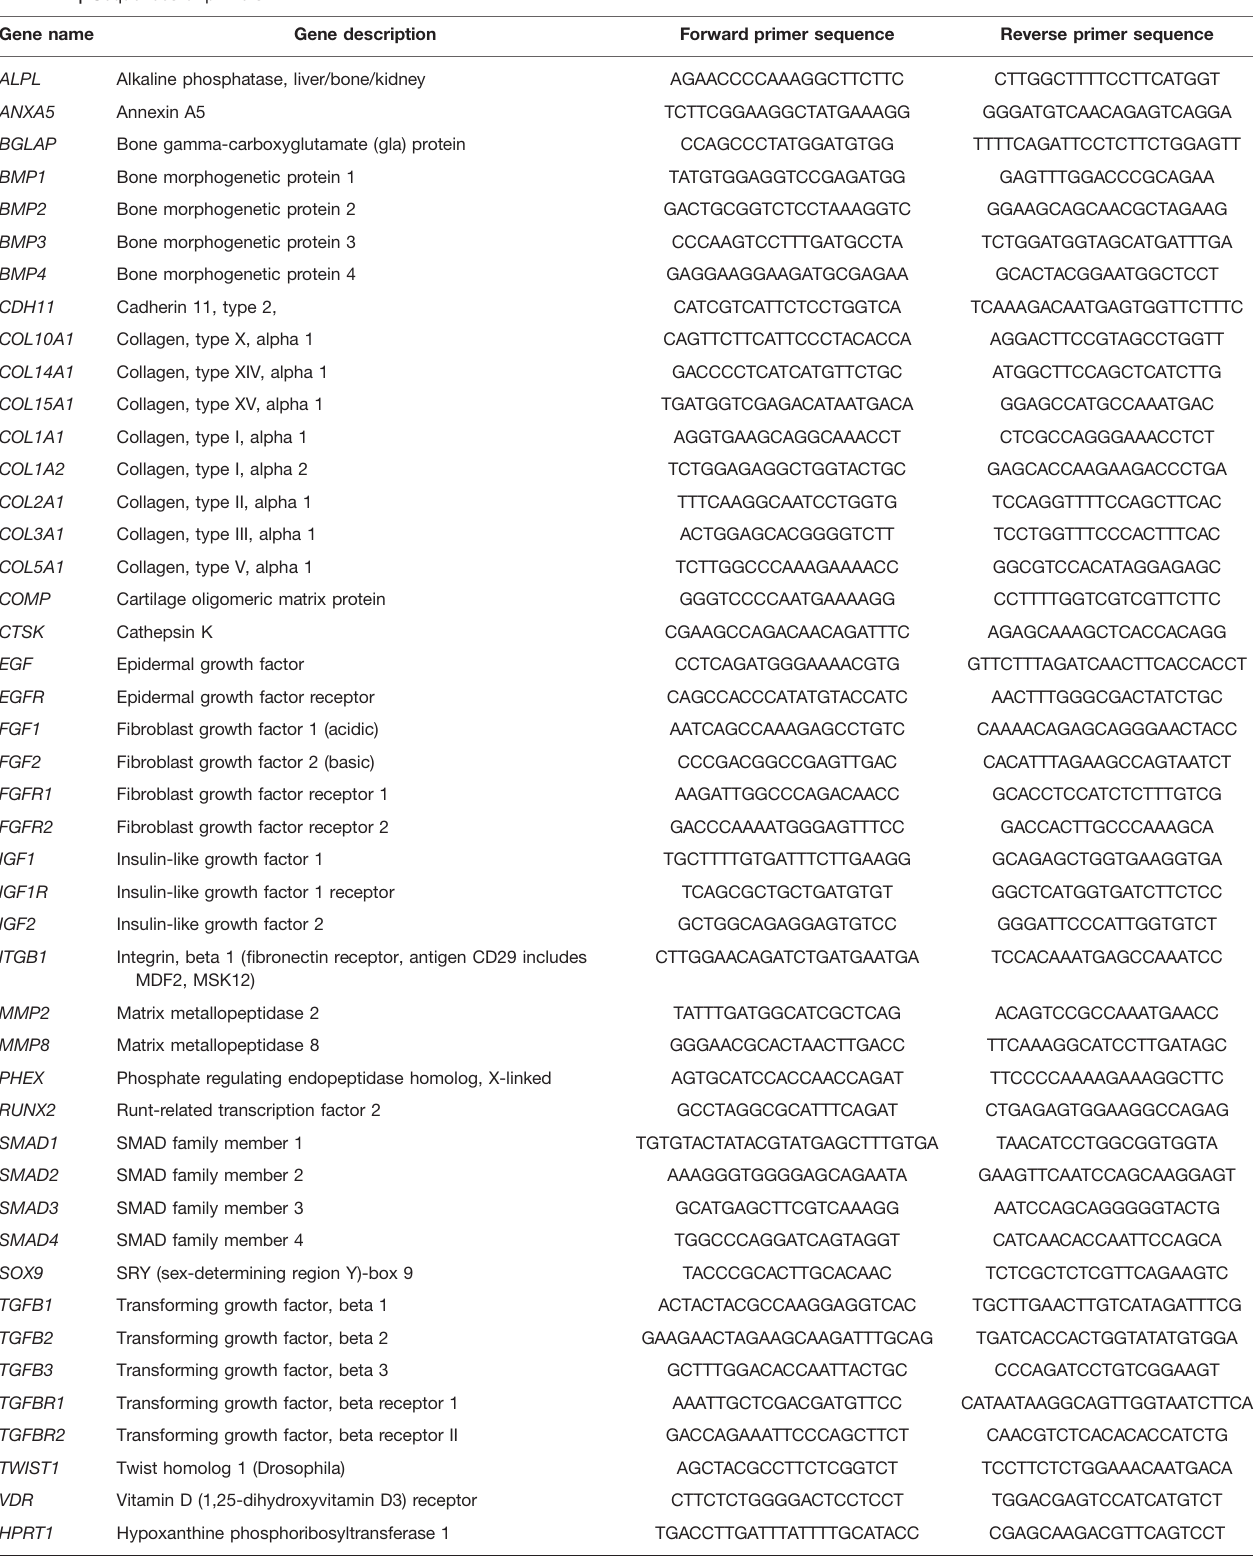
TABLE 1 | Sequences of